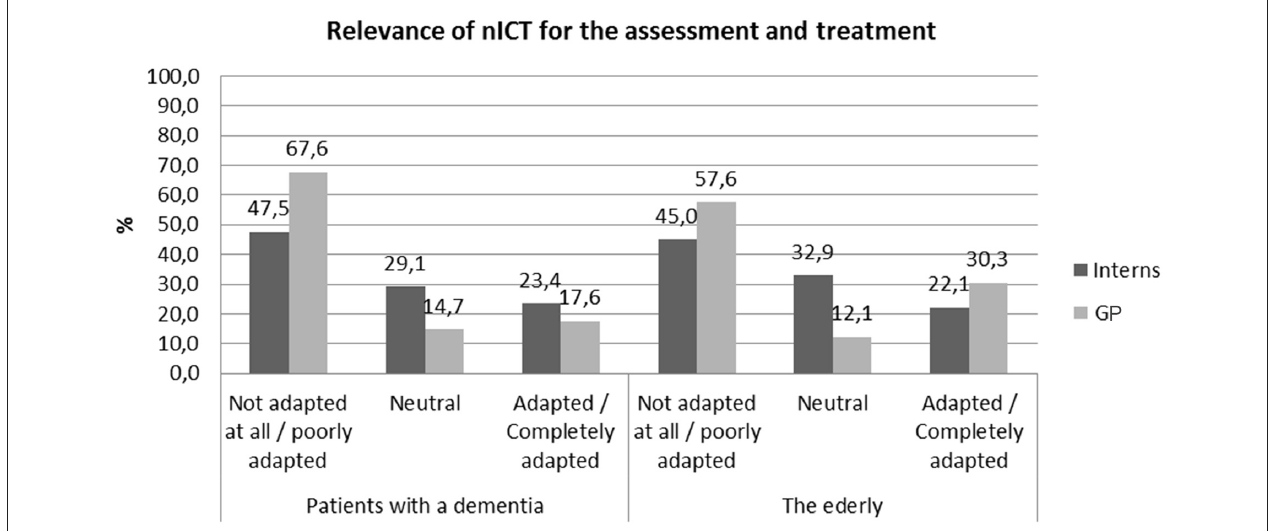
FIGURE 1 | Relevance of information and communication technologies (ICT) for different affective/emotional